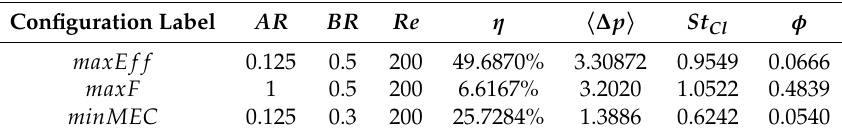
Figure 12. Performance of the minMEC micro heat exchanger near the rectangular structure. ( a ) Dimensionless velocity vector field; ( b ) Dimensionless static pressure (with mixing structures on top) ( c ) Streamlines (dimensionless velocity coloured scale); ( d ) Dimensionless vorticity. Table 2. Efficient configurations for thermal mixing